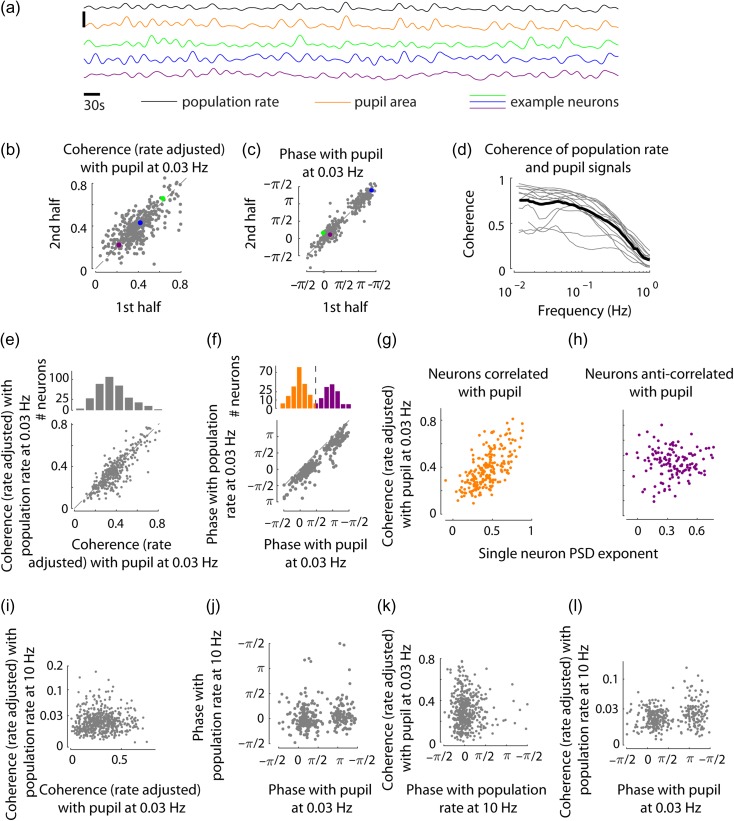
Global origin of infraslow dynamics. (a) Population rate, pupil area and spiking activity of example neurons during 1000 s portion of a recording. For presentation purposes only, signals were low-pass filtered below 0.05 Hz and z-scored, vertical scale bar is 5 standard deviations. (b, c) Magnitude (rate adjusted) and phase of coherency of individual neurons (n = 350, from 13 recordings) with pupil area signal, separately estimated from 2 halves of each recording, shown for an example frequency of 0.03 Hz. In b, R2 = 0.42 (P < 10−50). In c, average absolute discrepancy between the 2 halves: 0.34 ± 0.35 rad, explained circular variance: 0.88 (P < 10−16). Colored dots represent the example neurons shown in a. (d) Coherence between population rate and pupil area, in individual recordings (gray, n = 13 recordings in 5 animals) and in their average (black). (e, f) Top: Distribution of coherency magnitude (rate adjusted) and phase of individual neurons’ spiking with respect to the pupil area signal at 0.03 Hz. Bottom: magnitude and phase of coherency of individual neurons with pupil area vs their coherency with population rate. R2 = 0.67 (P < 10−90) in e, 0.85 explained circular variance (P < 10−16) in f. (g) The slope of power-law fit to the infraslow PSD portion (in 0.01–1 Hz) of each neuron was positively correlated with the rate adjusted coherence with pupil (at 0.03 Hz), for neurons whose phase with respect to pupil fluctuation was close to 0 (the left peak in the bimodal histogram in f, shown in orange; r = 0.64, P < 10−9). (h) No significant correlation was found between the PSD power-law slope and pupil coherence for neurons whose phase with respect to the pupil was close to π (the right peak in the bimodal histogram in f, shown in purple; P = 0.66). (i, j) Coherence (phase) of individual neurons with pupil signal on slow timescale (0.03 Hz) and their coherence (phase) with population rate on fast timescale (10 Hz) are uncorrelated (P = 0.85, Spearman correlation in i, P = 0.31, circular correlation in j). (k) Fast timescale phase was uncorrelated with coherence with the pupil (P = 0.77). (l) A significant correlation between phase with pupil at 0.03 Hz and coherence with population rate at 10 Hz (P < 0.001) was observed, where neurons anticorrelated with the pupil were more coherent with population rate on fast timescales.